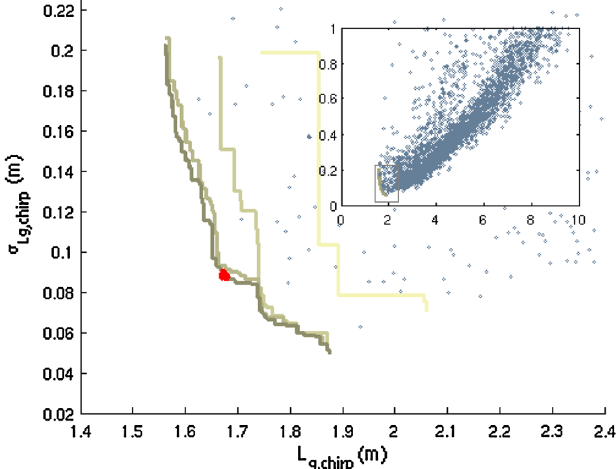
FIG. 3. Pareto-optimal fronts for the optimization of the ob- jective with the NSGA-II MOGA. The four hues of green refer to the 5, 25, 50, and 100 iteration fronts. A comparison with the result of a random search (blue dots) is reported. The inset shows the zoom of the optimal front in the best region of the objective. The red dot shows a chosen solution whose parameters are plotted in Fig. 4 (see text for more